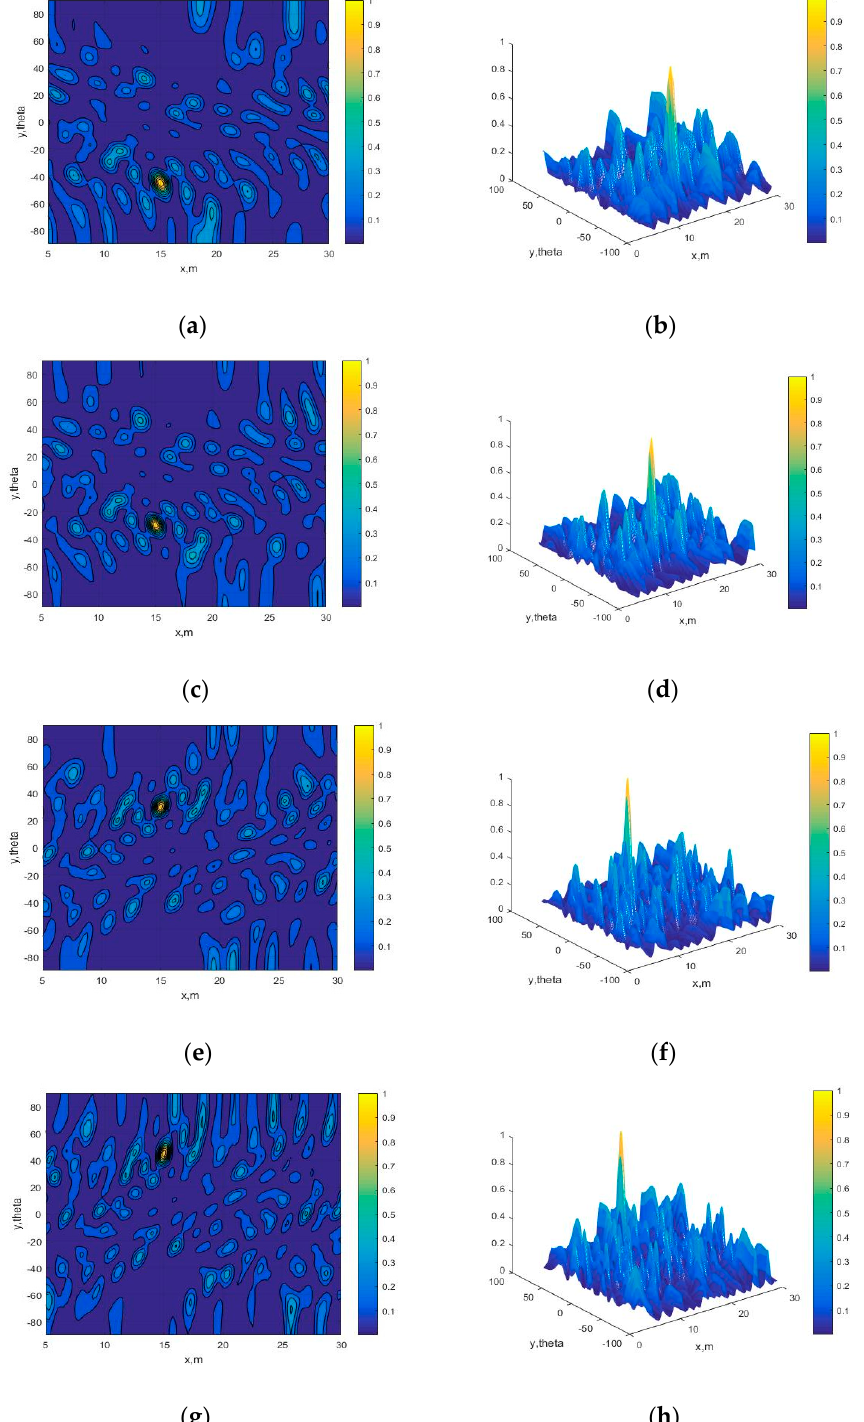
Figure 5. Multi-point sequential focus: ( a ) top view of focus at t = 0 ns; ( b ) side view of focus at t = 0 ns; ( c ) top view of focus at t = 5 ns; ( d ) side view of focus at t = 5 ns; ( e ) top view of focus at t = 10 ns; ( f ) side view of focus at t = 10 ns; ( g ) top view of focus at t = 15 ns; ( h ) side view of focus at t = 15 ns.